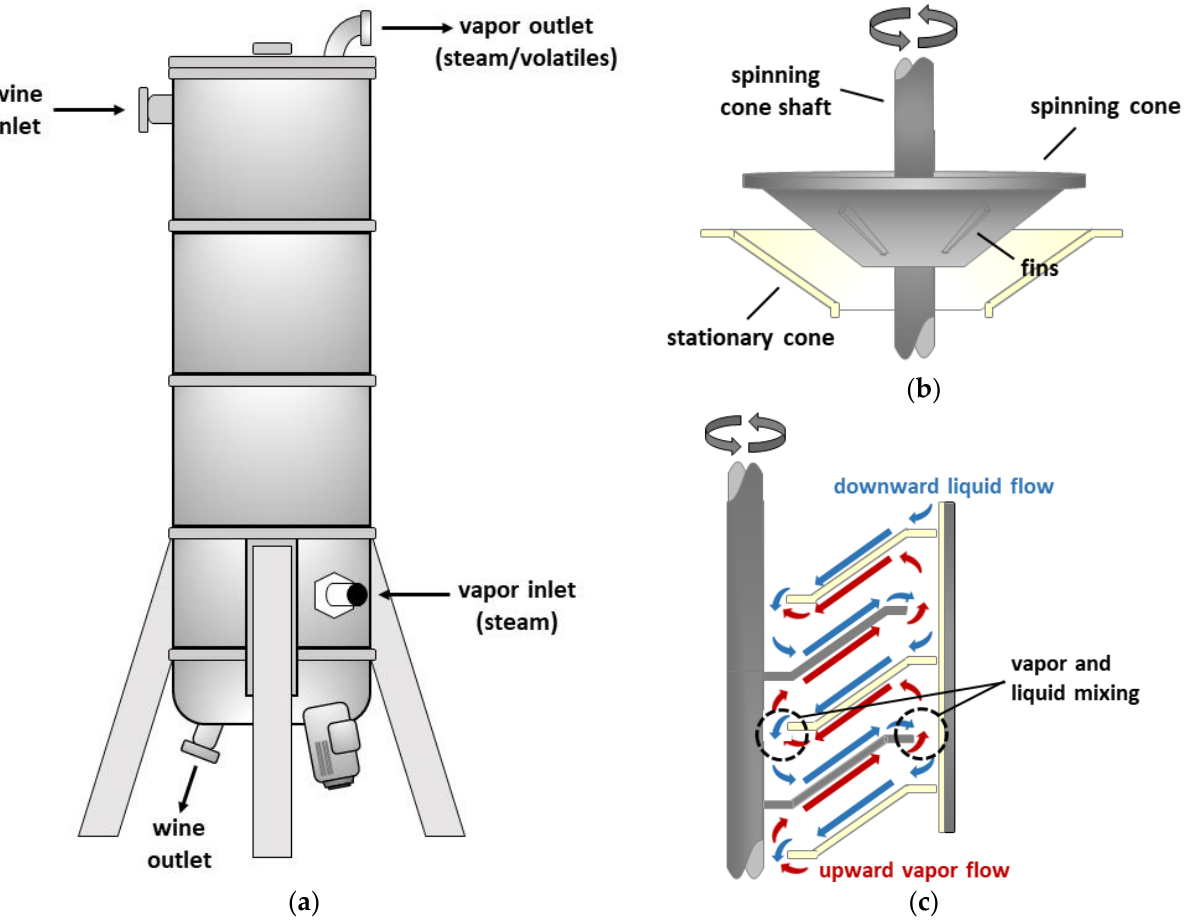
Figure 1. Schematic diagram of: ( a ) a spinning cone column distillation system; ( b ) a set of rotating and stationary cones; and ( c ) the downward flow of liquid and upward flow of vapor within the spinning cone column during operation.